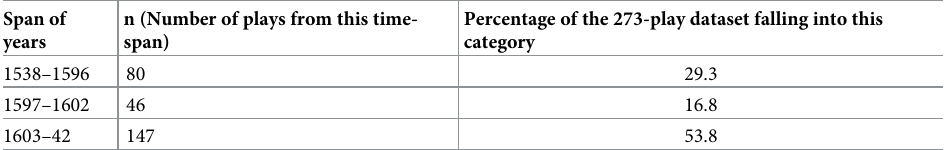
Table 1. Plays segmented into three